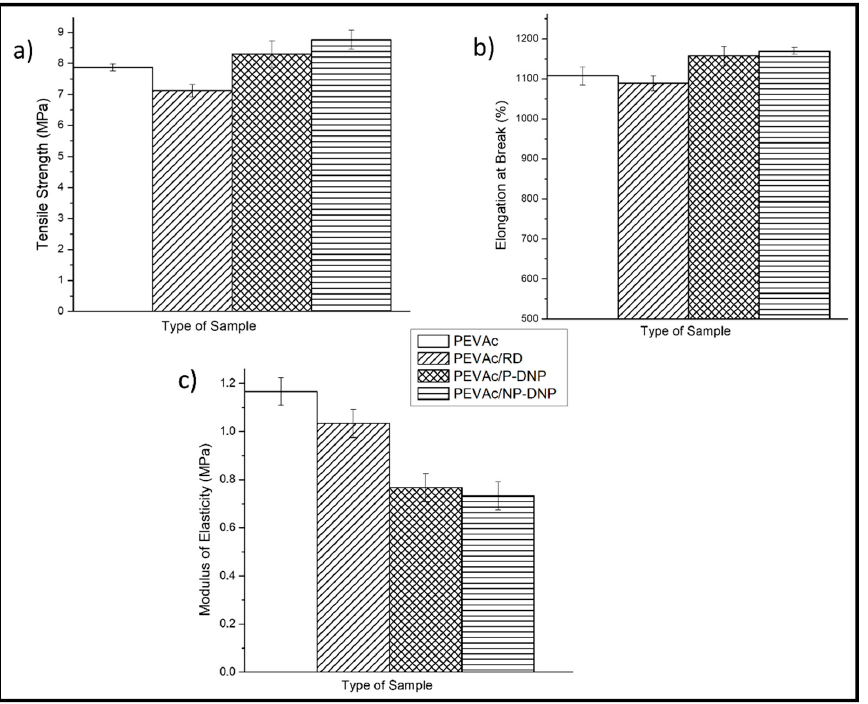
Figure 11. Tensile properties of PEVAc containing raw dolomite (RD), dolomite nanoparticles (DNPs), or non-polar dolomite nanoparticles (NP-DNPs): ( a ) tensile strength, ( b ) elongation at break, and ( c ) modulus of elasticity. Table 3. Tensile properties of raw dolomite (RD), dolomite nanoparticles (DNPs), and non-polar dolomite nanoparticles